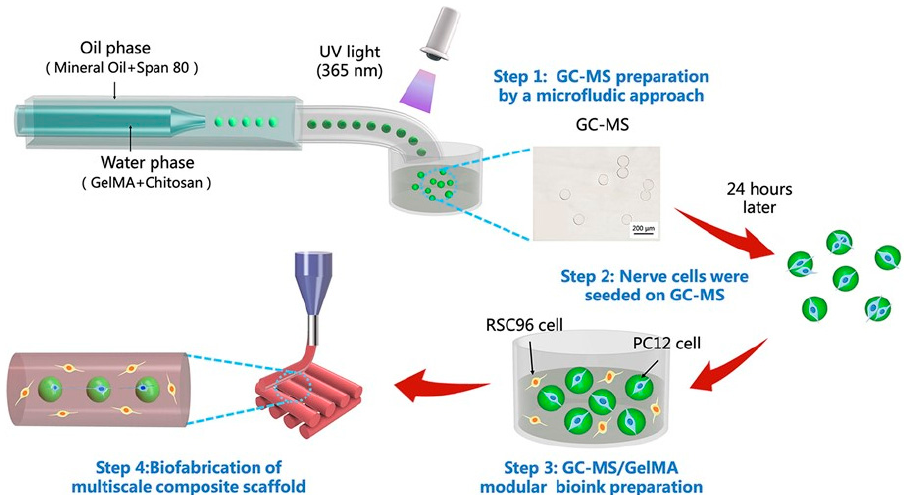
Figure 7. Flowcharts of microfluidic and 3D printing for the preparation of hydrogel neural scaffolds. (Reprinted with permission from Ref. [172]. 2020, Elsevier).